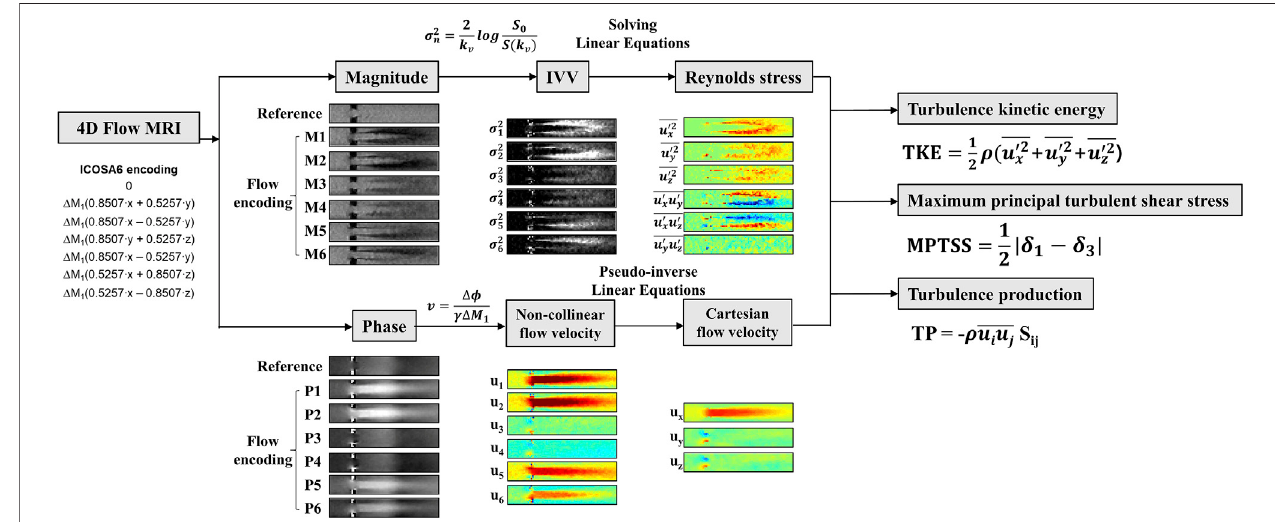
FIGURE 3 | Illustration of Reynolds stress measurement and turbulence parameter analysis.